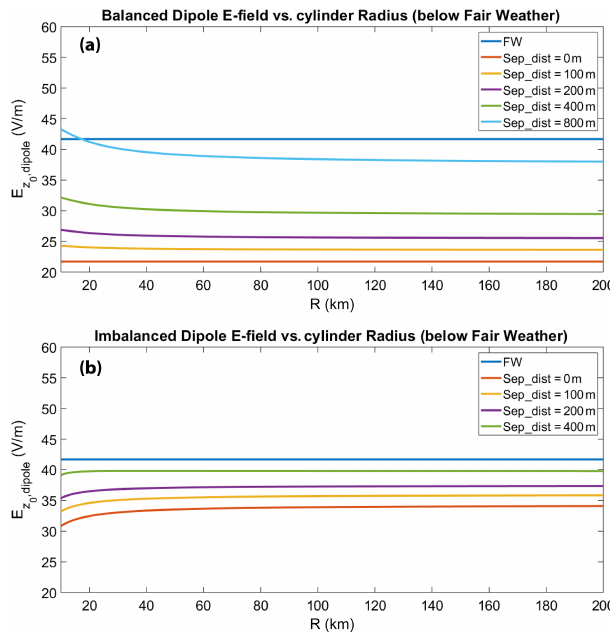
Figure 4. Vertical electric field strength at ground level ( E z below the fair-weather field (blue line), for a dipole of (a) finite uniformly charged cylinders and (b) non-uniformly charged cylin- ders exhibiting a charge imbalance of 8%, within an elevated dust layer as a function of the cylinder radius R . E z for separation distances (Sep_dist) of 0 (electrically neutral dust), 100, 200, 400 and 800m (balanced dipole case only) between the charged